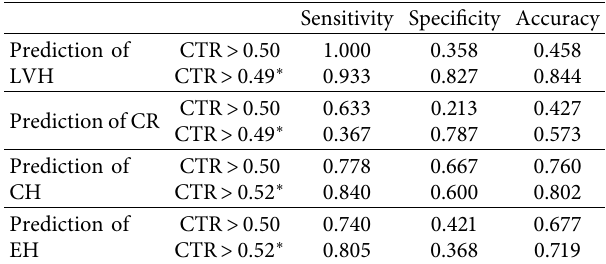
Table 6: Sensitivity, specificity, and accuracy of the radiographic cardiothoracic ratio as a predictor of left ventricular